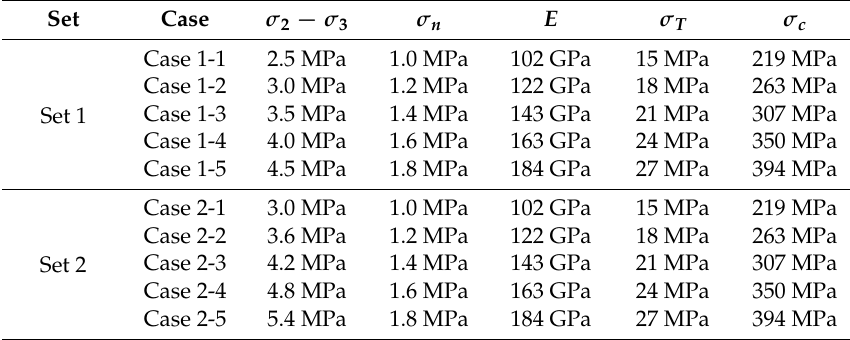
Table 6. Modelling scenarios for studying the validity of Equation (1). The values of parameters related to the differential stress, the net pressure and rock properties in Cases 1-2 to 1-5 (Cases 2-2 to 2-5) are increased by 20%, 40%, 60% and 80 % respectively compared with that in Case 1-1 (Case 2-1) with the values of other input parameters remaining consistent. The ( σ 2 − σ 3 )/ σ n ratios of modeling Sets 1 and 2 are kept constant as 2.5 and 3 respectively. The σ c magnitudes in Cases 1-4 and 1-5 (Cases 2-4